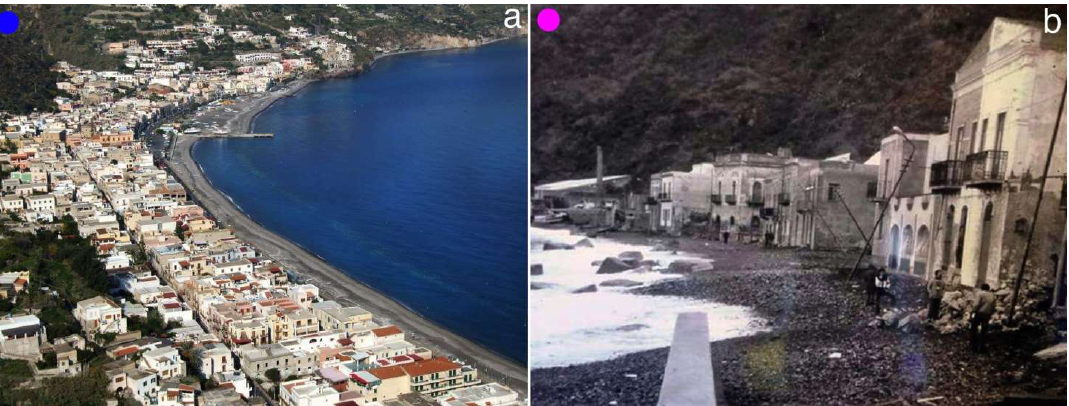
Figure 9. ( a ) Image of Canneto bay, with the central pier intercepting the littoral drift from N to S. The submerged breakwaters are also visible in the coastal area, south of the pier; ( b ) image of the southernmost beach of Canneto during a storm. Location of pictures is in Figure 1 through respective colored dots.